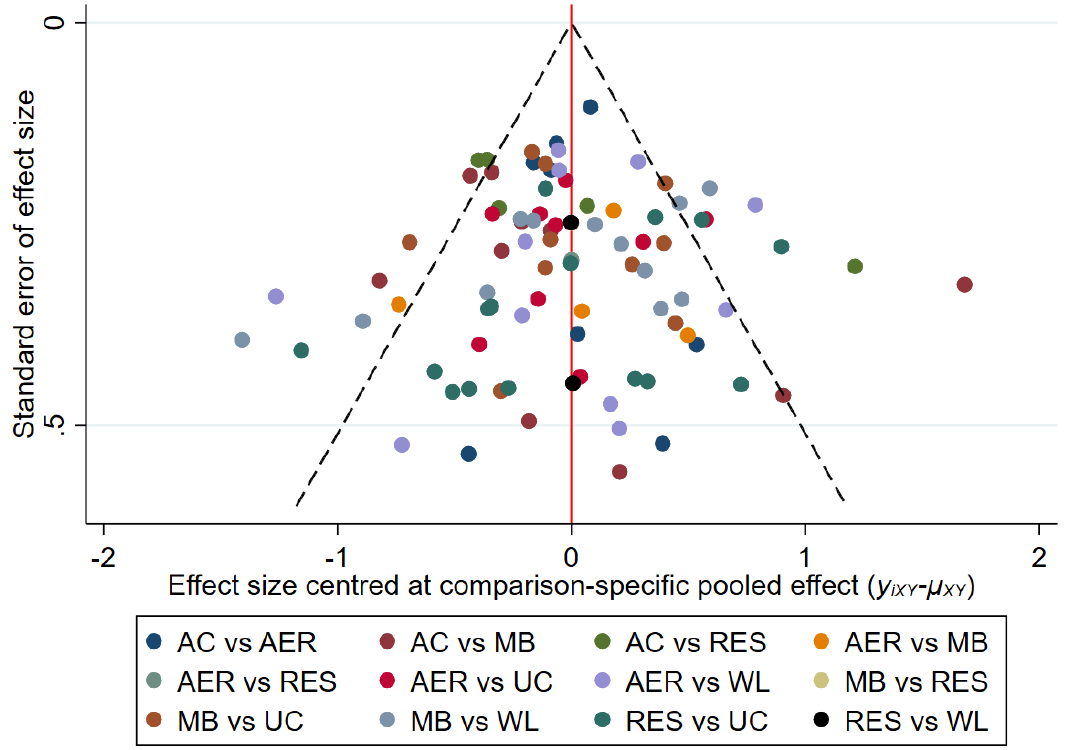
Figure 4. Comparison-adjusted funnel plot for the depressive symptoms network. The red vertical line represents the null hypothesis that independent effect size estimates are not different to comparison-specific pooled estimates. AC = attention-control; AER = aerobic; MB = mind-body; RES = resistance; UC = usual care; WL = wait-list.